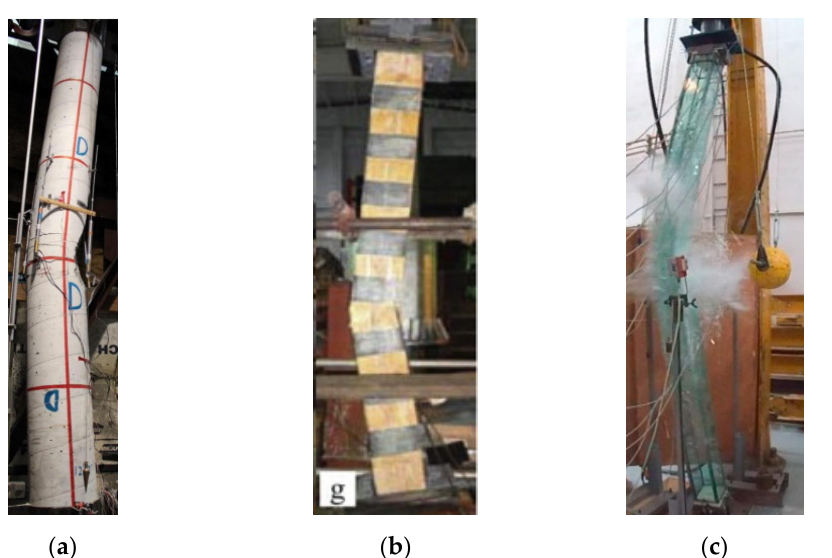
Figure 1. Examples of column buckling for constructional members: ( a ) FRP-reinforced concrete columns (reproduced from [2] with permission from Elsevier ® , license n. 5026030791841); ( b ) repaired timber columns (reproduced from [3] with permission from Elsevier ® , license n. 5026030922470); and ( c ) hollow square glass columns (reproduced from [4] with permission from Elsevier®, license n. 5026031011542).